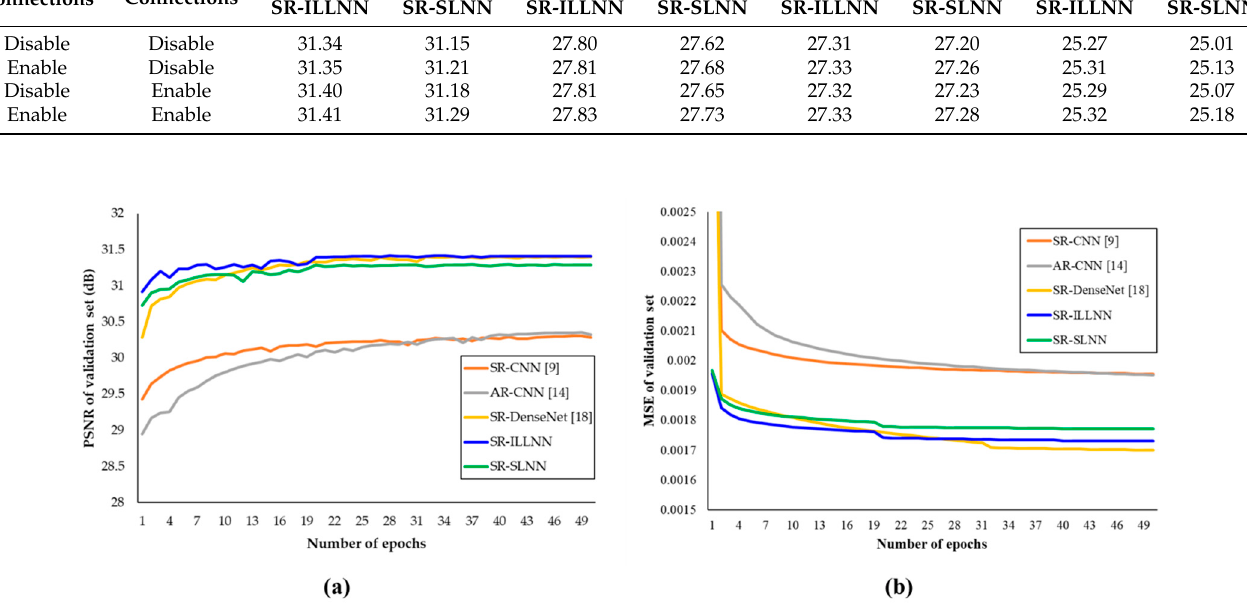
Figure 6. PSNR and MSE corresponding to the number of epochs. ( a ) PSNR per epoch. ( b ) MSE per epoch.